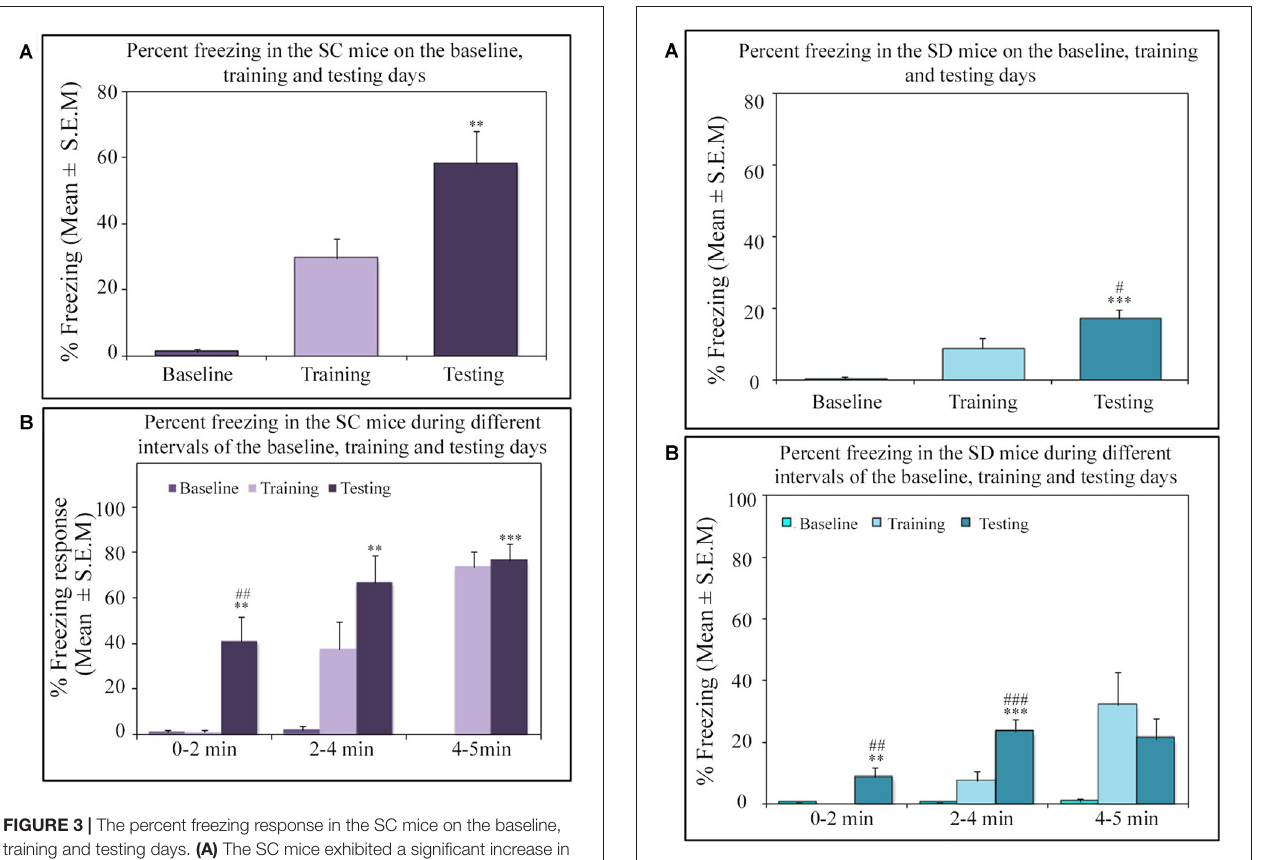
FIGURE 4 | The percent freezing response in the SD mice on the baseline, training and testing days. (A) The SD mice also exhibited a significant increase in percent freezing ( p < 0.001, F ( 2,17 ) = 22.16) on the testing day (compared to baseline day: Tukey p < 0.001 and compared training day: Tukey p < 0.05). (B) The percent freezing significantly increased on the testing day only during the 0–2 min (compared to baseline day: Tukey p < 0.01; compared to training day: Tukey p < 0.01) and 2–4 min (compared to baseline day: Tukey p < 0.001; compared to training day: Tukey p < 0.001) time periods (the corresponding times of pre-shock, shock and post-shock periods of the training day). ∗∗ p < 0.01 and ∗∗∗ p < 0.001 (compared to baseline day); # p < 0.05, ## p < 0.01 and ### p < 0.001 (compared to training